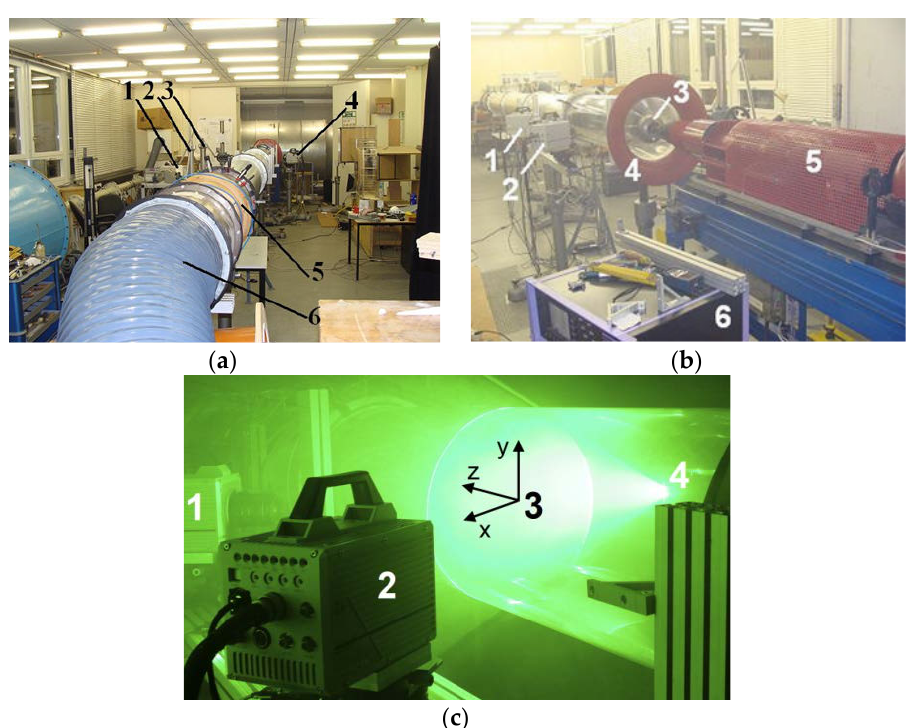
Figure 2. Test rig: ( a ) 1—Nd:YLF laser, 2 and 3—Betz micro- manometers, 4—PIV fast cameras, 5—Venturi flow meter, and 6—flexible hose; ( b ) 1—left PIV fast camera, 2—right PIV fast camera,